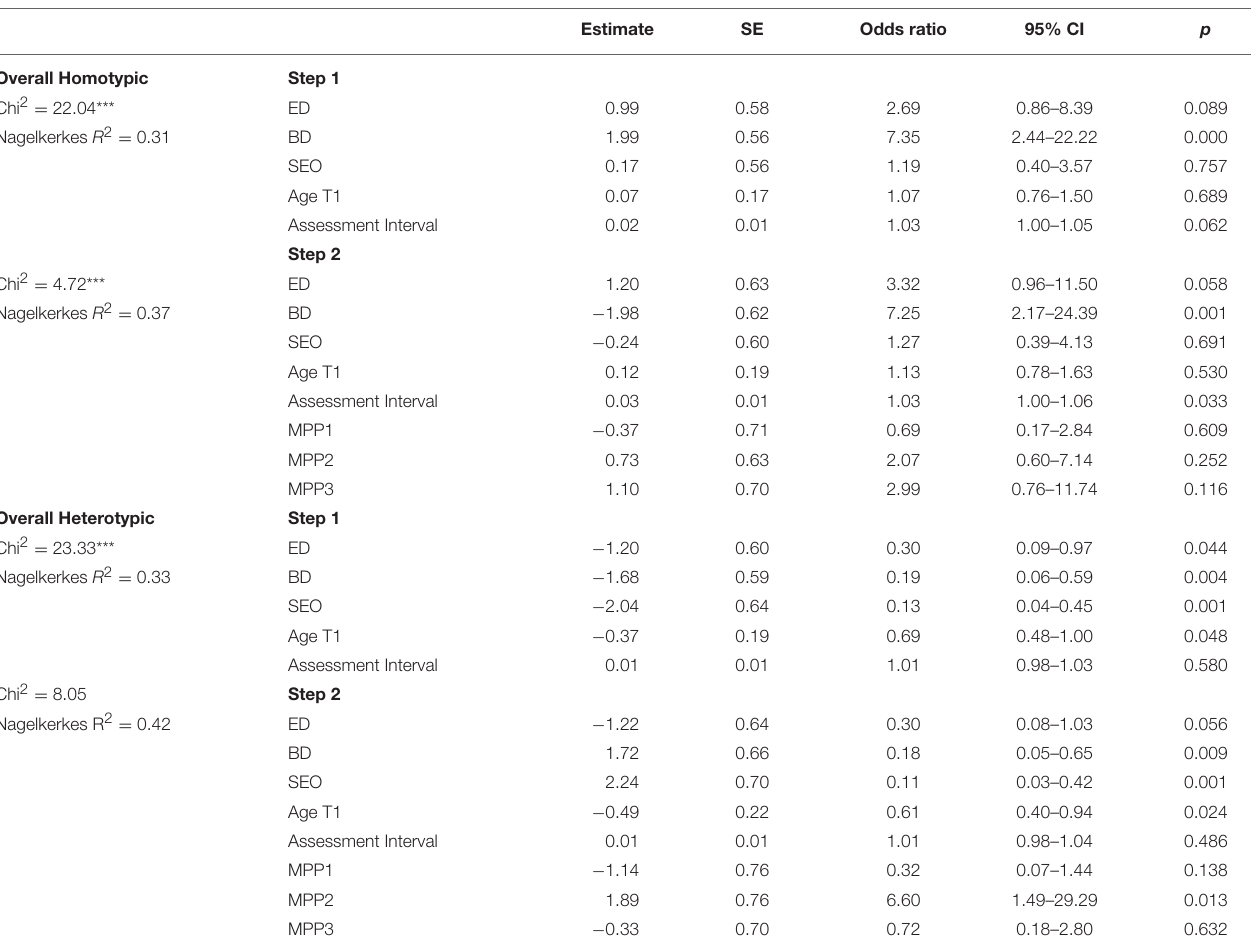
TABLE 3 | Hierarchical multiple logistic regression to predict homo- and heterotypic clinical trajectories depending on clinical disorder cluster (ED, BD, SEO; see text), sociodemographic variables (age, assessment interval), and maternal psychopathology as a moderator variable. Estimate SE Odds ratio 95% CI